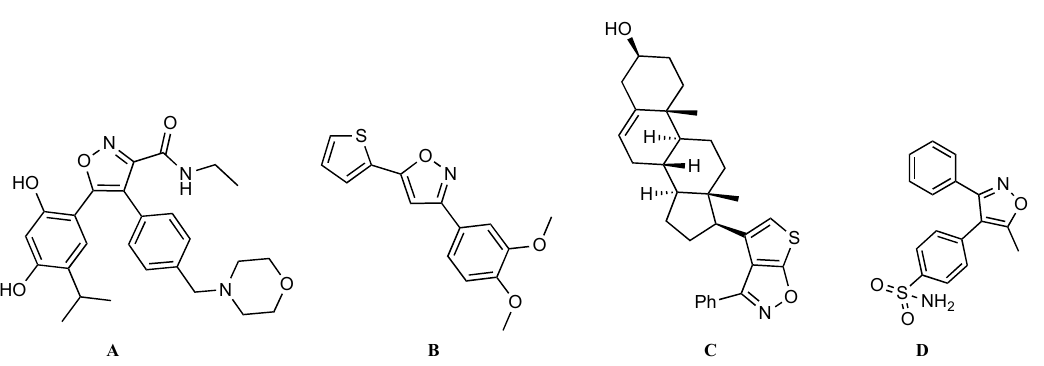
Figure 1. Selected examples of bioactive isoxazoles: A , B and C , 3,4,5-isoxazole and fused isoxazole derivatives with anticancer; and D , 3,4,5-isoxazole derivative with anti-inflammatory activity.